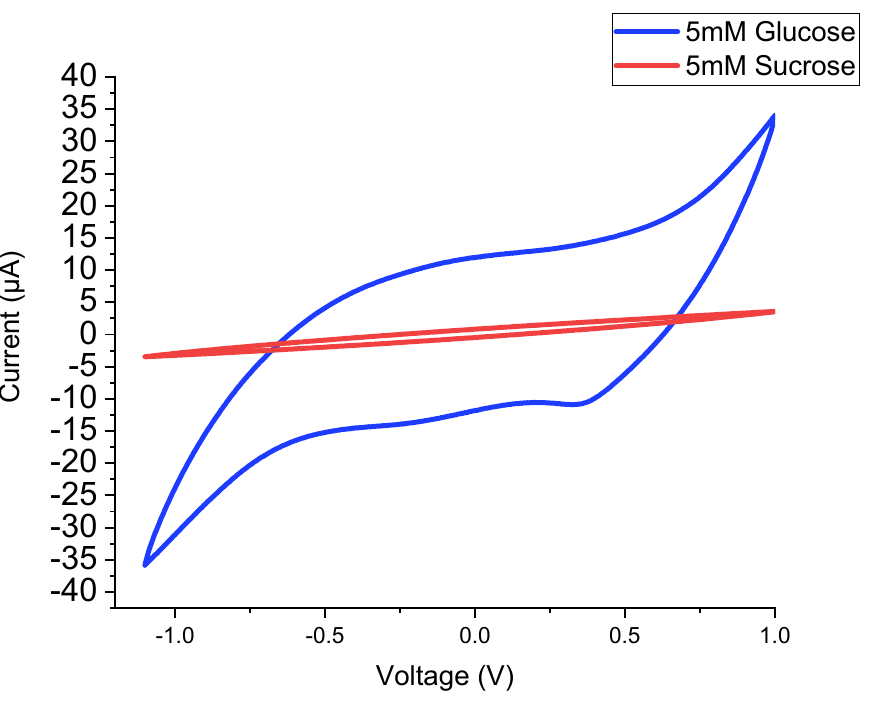
Figure 9. CV curves without a buffer (NaOH). The blue curve represents the response to 5 mM glucose. The red curve represents the response to 5 mM sucrose.